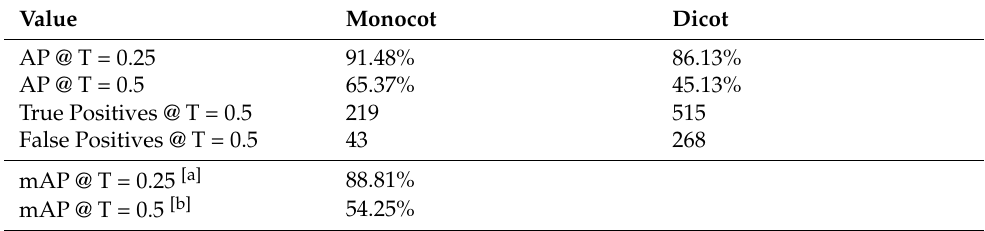
Table 7. Continued network training results for Training Image Set 4 (Set